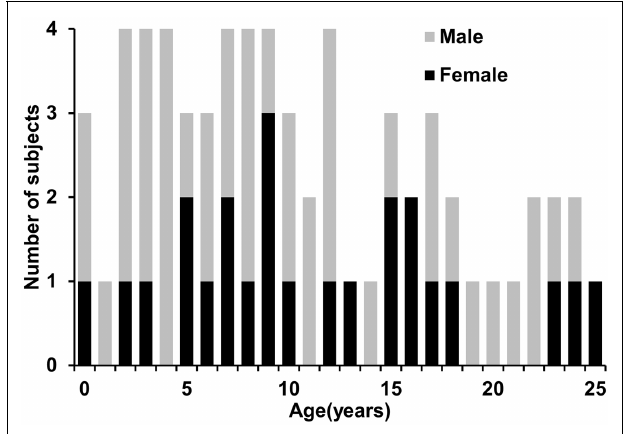
FIGURE 1 |Age and gender distribution of the 65 normal developing human subjects